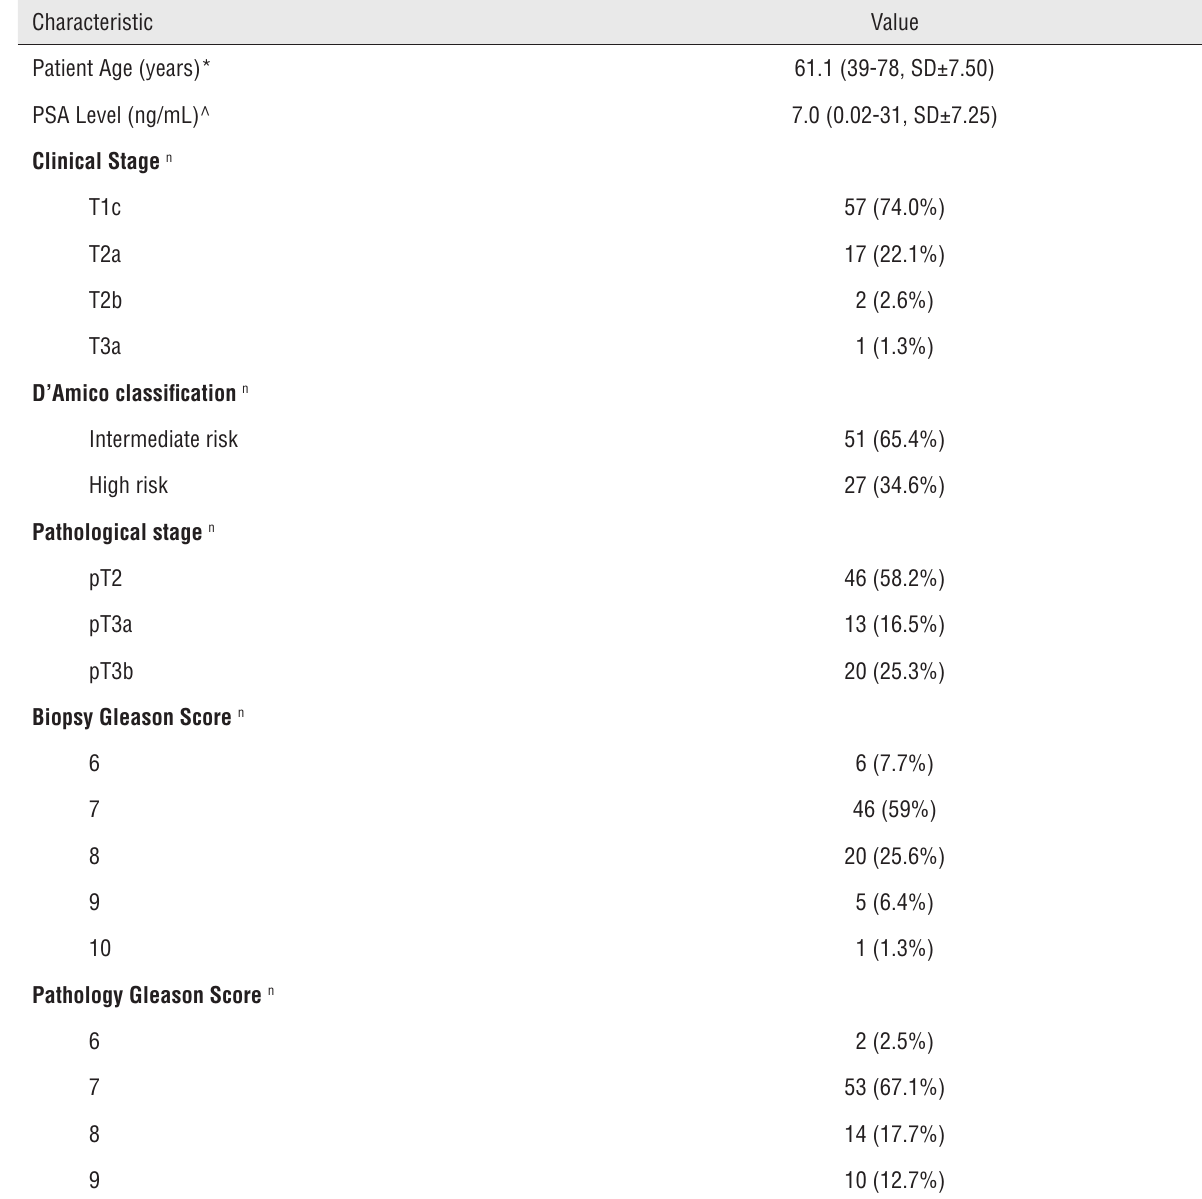
Table 1 - Patient and disease